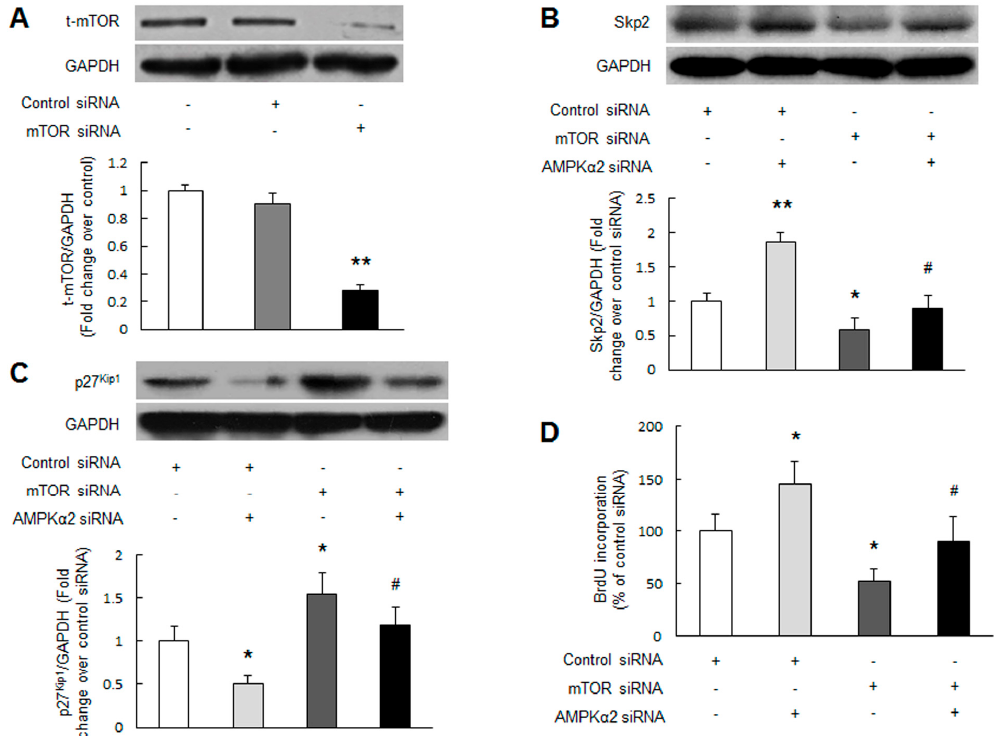
Figure 3. mTOR mediates AMPK α 2 knockdown-induced Skp2 upregulation, p27 Kip1 downregulation and PASMCs proliferation. ( A ) Primary cultured PASMCs were transfected with mTOR